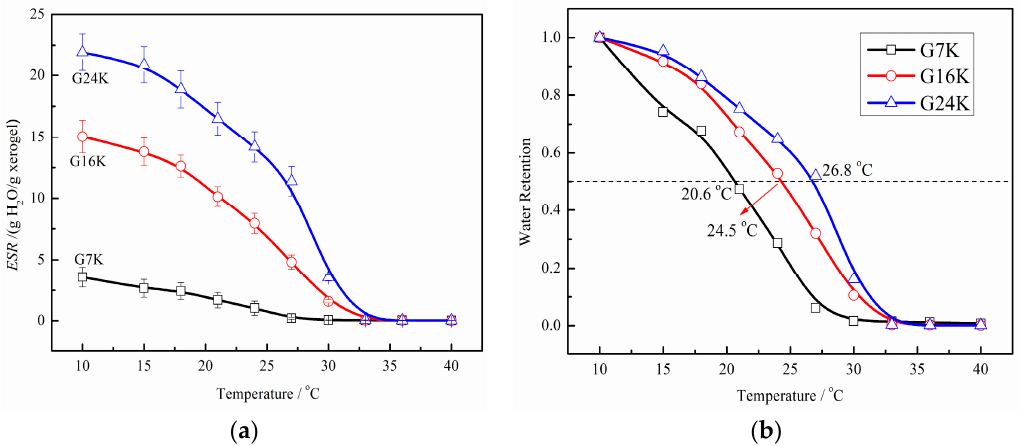
Figure 5. ( a ) The effect of temperature on ESR of click PNIPA hydrogels; ( b ) water retention of samples at different temperatures relative to ESR at 10 °C.